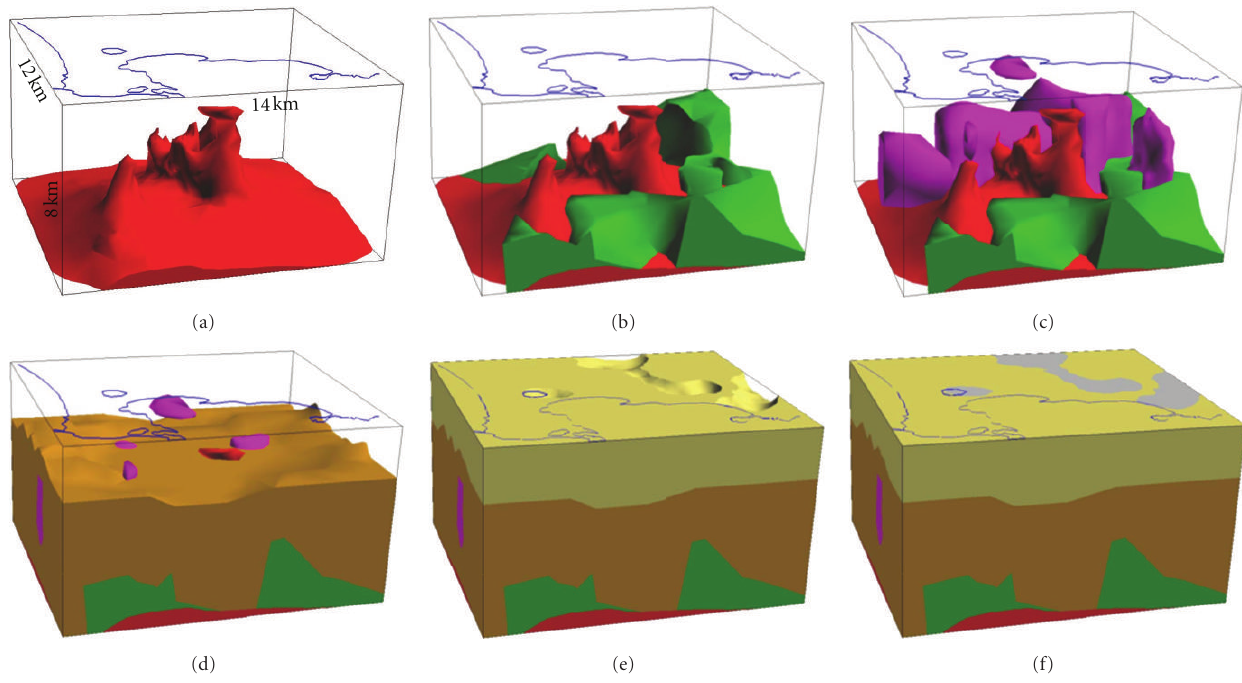
Figure 3: 3D model: internal structure. See Table 1 for the description of the lithological